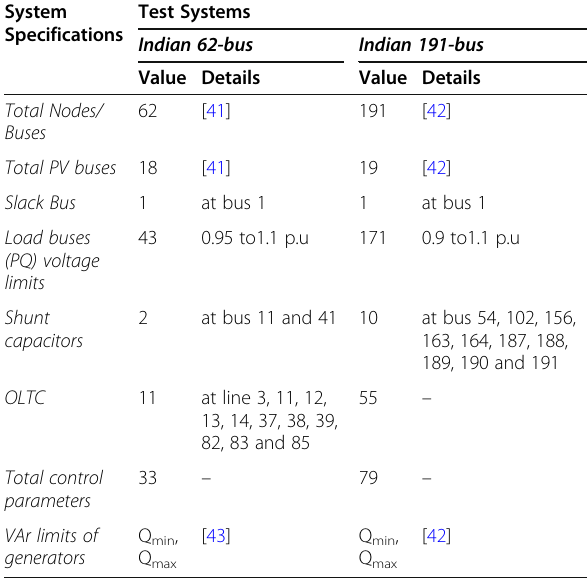
Table 6 Details of the practical test systems System Test Systems Specifications